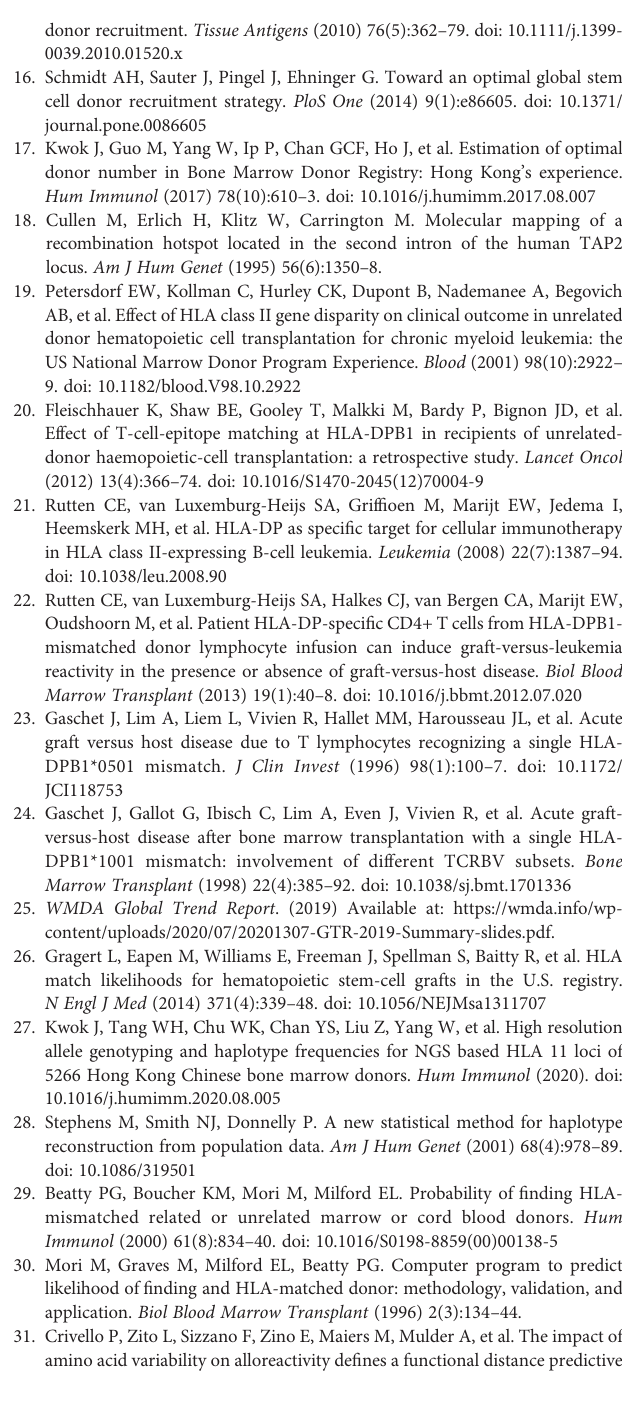
Supplementary Table 1 | 81 Combinations of DPB1 TCE v2 assignment and matching